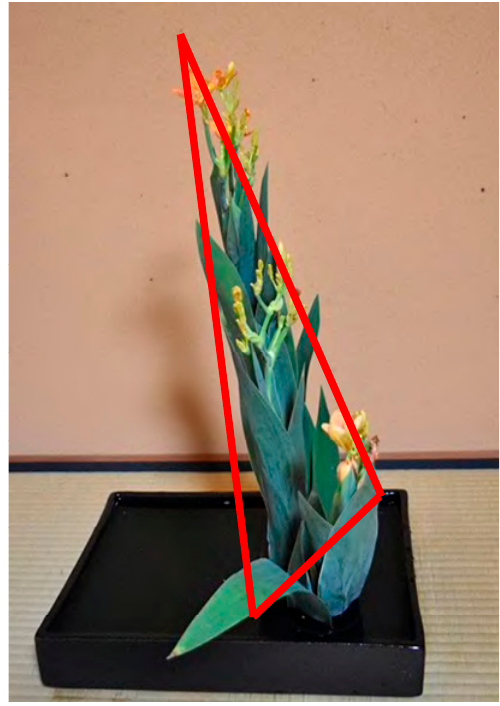
Figure 3. “Basic Form” of Ikebana. (in public domain).